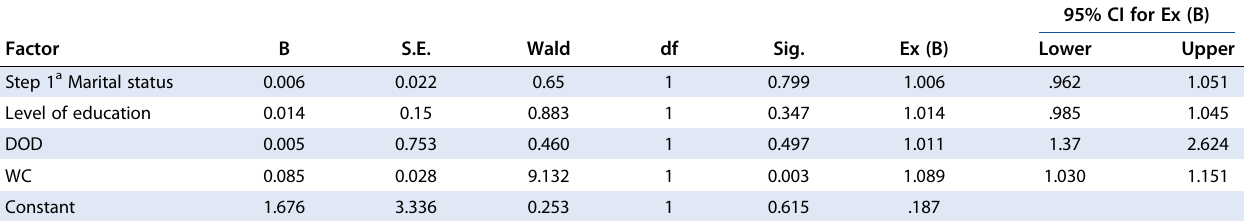
Table 5: SPSS multivariate logistic regression output (variables in the equation) of factors associated with poor glycaemic control at DGMAH